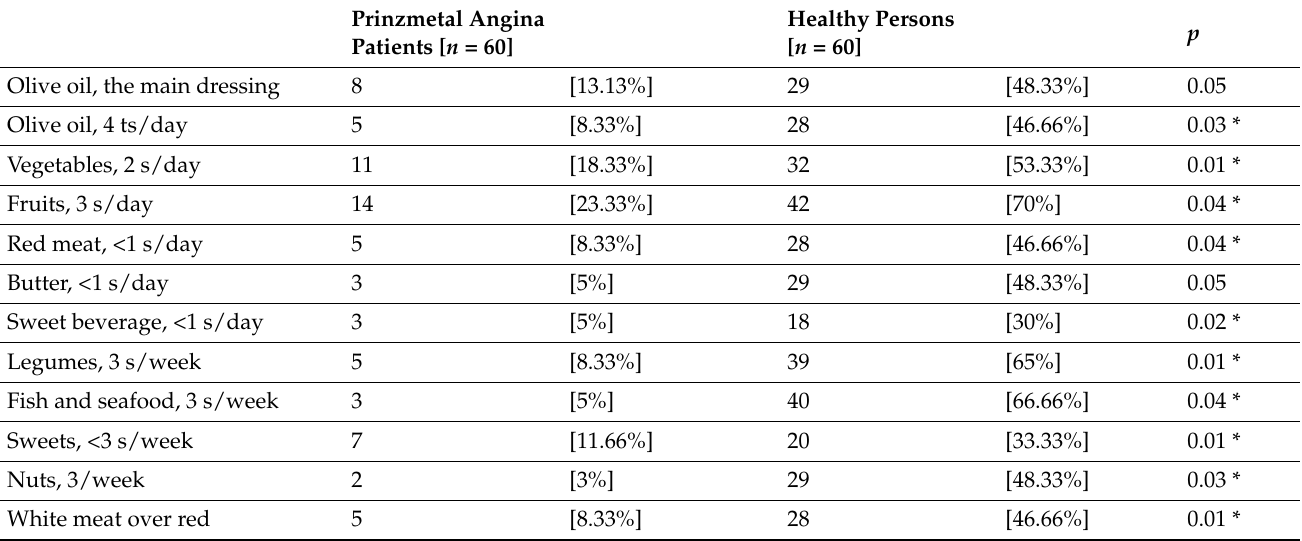
Table 4. Positive answers to the MEDAS